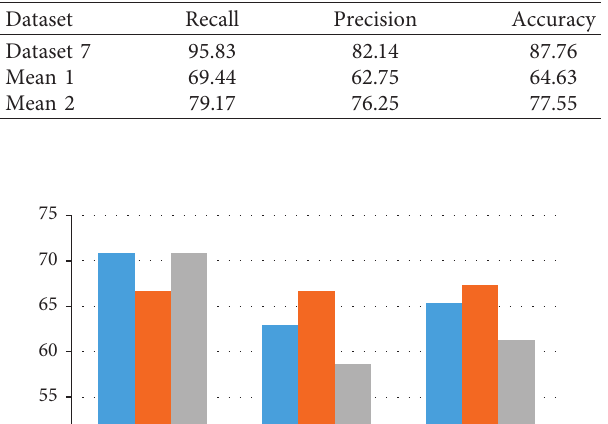
Table 7: Results of SVM model for Dataset 7 and mean values.